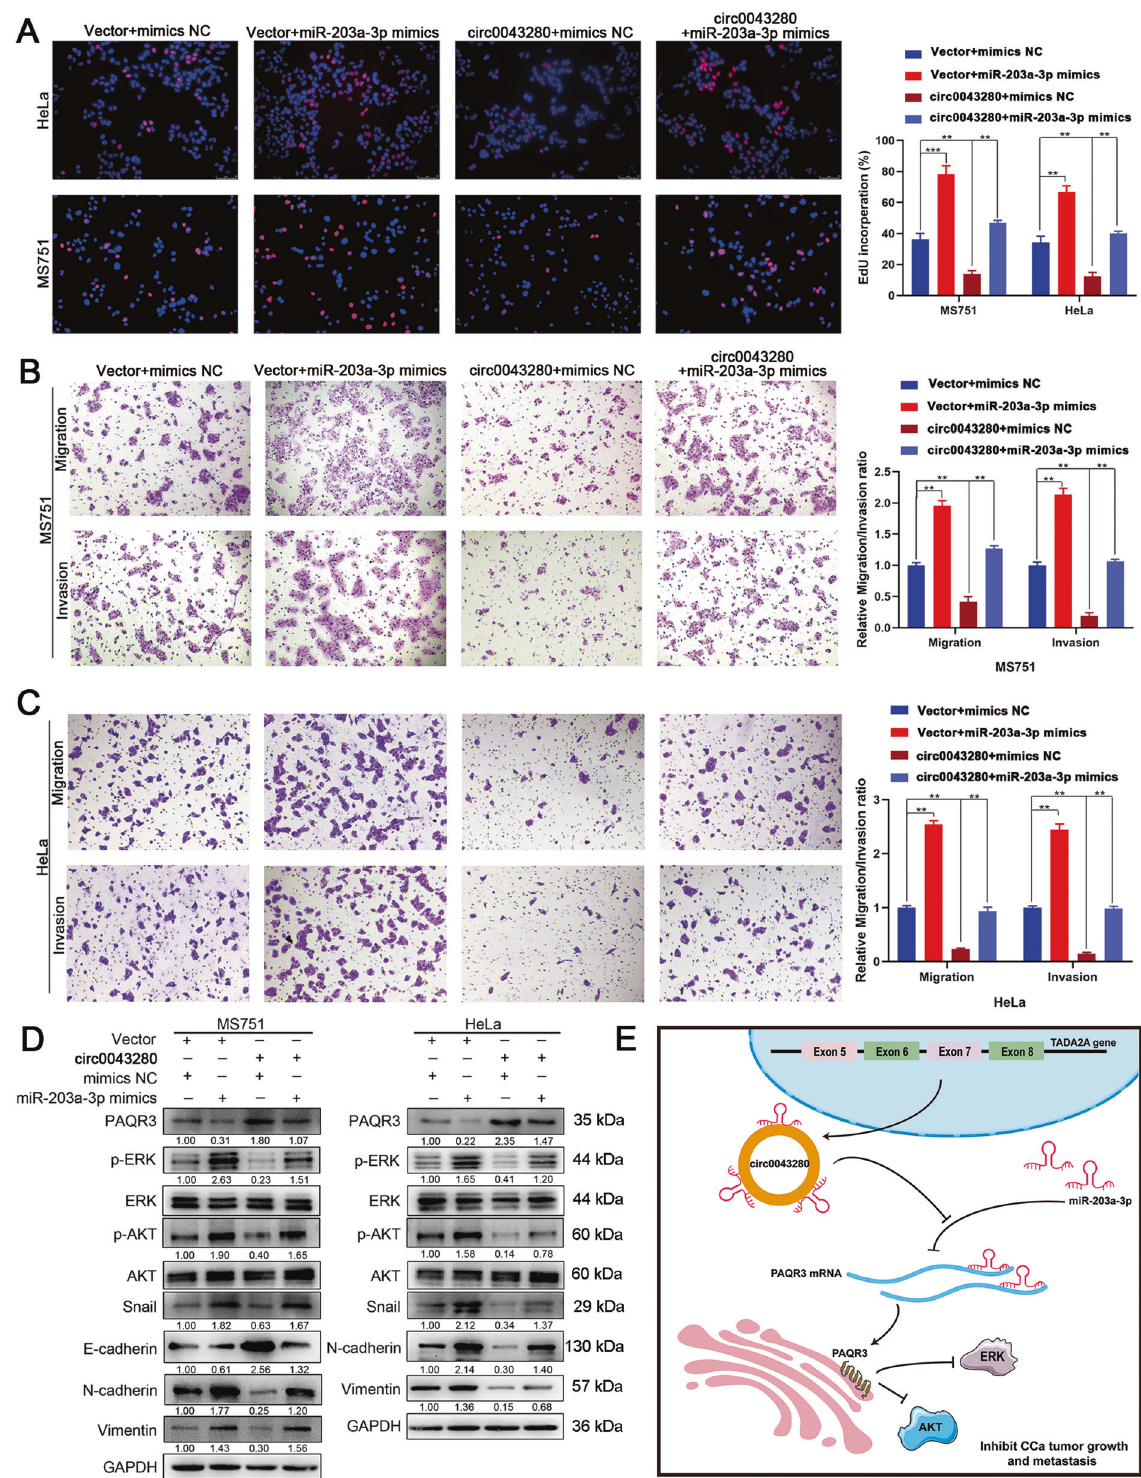
Fig. 7 Hsa_circ_0043280 inhibited the proliferation and metastasis of CCa via the miR-203a-3p/PAQR3 axis. A The proliferative abilities of MS751 and HeLa cells were detected by EdU assays in the indicated cells. Original magni fi cation, × 100. B , C Transwell assays were performed to investigate the migration and invasion abilities of MS751 and HeLa cell lines in the indicated groups. Original magni fi cation, × 100. D Western blot analysis of the protein levels of various EMT markers Snail, E-cadherin, N-cadherin and Vimentin, p-ERK, and p-AKT in the indicated cells. E Schematic illustrating the hsa_circ_0043280/miR-203a-3p/PAQR3 signaling pathways in CCa. Hsa_circ_0043280 regulates the expression of PAQR3 by sponging miR-203a-3p and repressing the tumor growth and metastasis of CCa. Each experiment was performed at least three times independently. ** P < 0.01; *** P < 0.001.